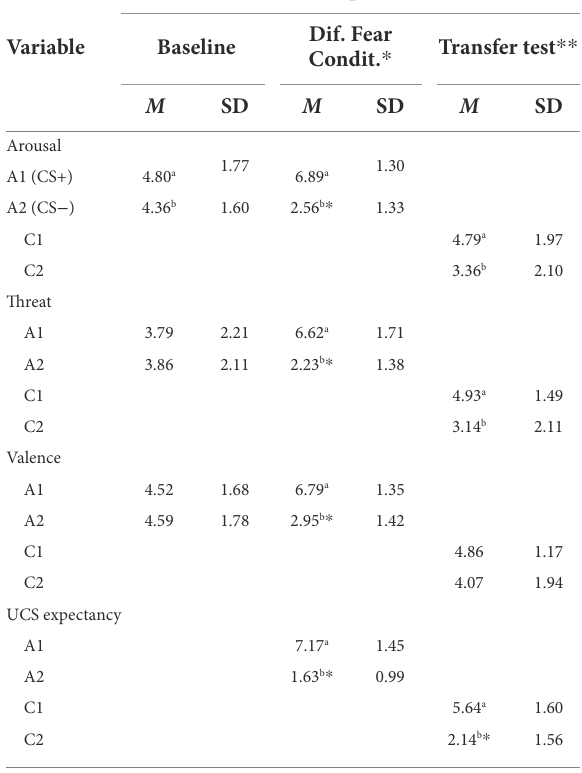
FIGURE 3 Flow of participants whose performance was analyzed through tests.